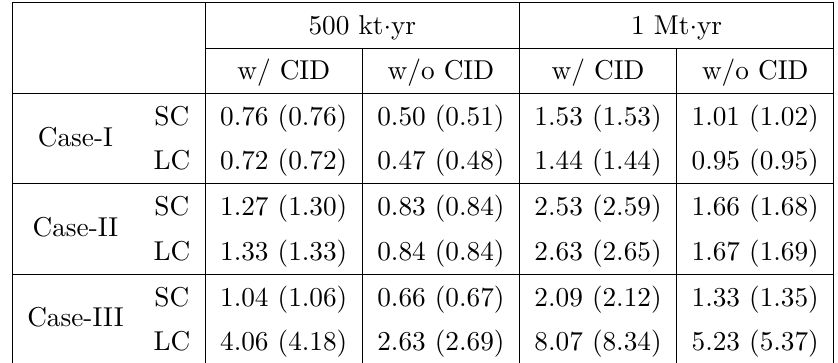
sensitivities for the modification of R by ± 500 km for all three cases with Table 5 . ∆ χ 2 CMB CMB an exposure of 500 kt · yr (10 years) and 1 Mt · yr (20 years). For the numbers without parentheses, the ∆ χ 2 minimization has been performed by varying test values of sin 2 θ and ∆ m 2 over 23 CMB eff their current uncertainties, and taking both mass orderings NO and IO. The numbers given in parentheses correspond to a fixed-parameter scenario where we do not marginalize over oscillation parameters in the fit. The results in the second and fourth (third and fifth) columns are with (without) charge identification. For simulating MC data, we use three-flavor neutrino oscillation parameters given in table 2, where we assume NO and sin 2 θ = 23